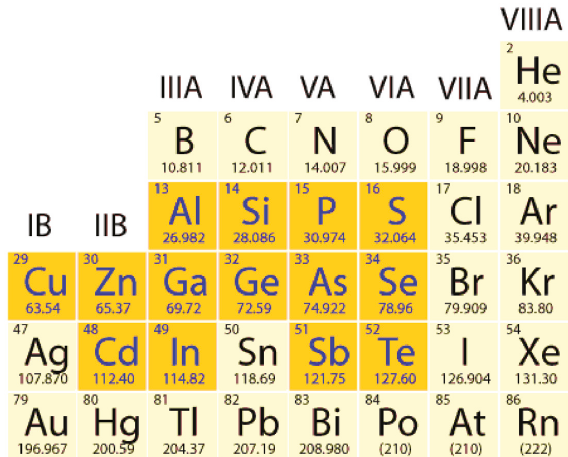
Figure 1: Periodic table of elements used for semiconductor manufacturing (https://bit.ly/3M7PLEV).